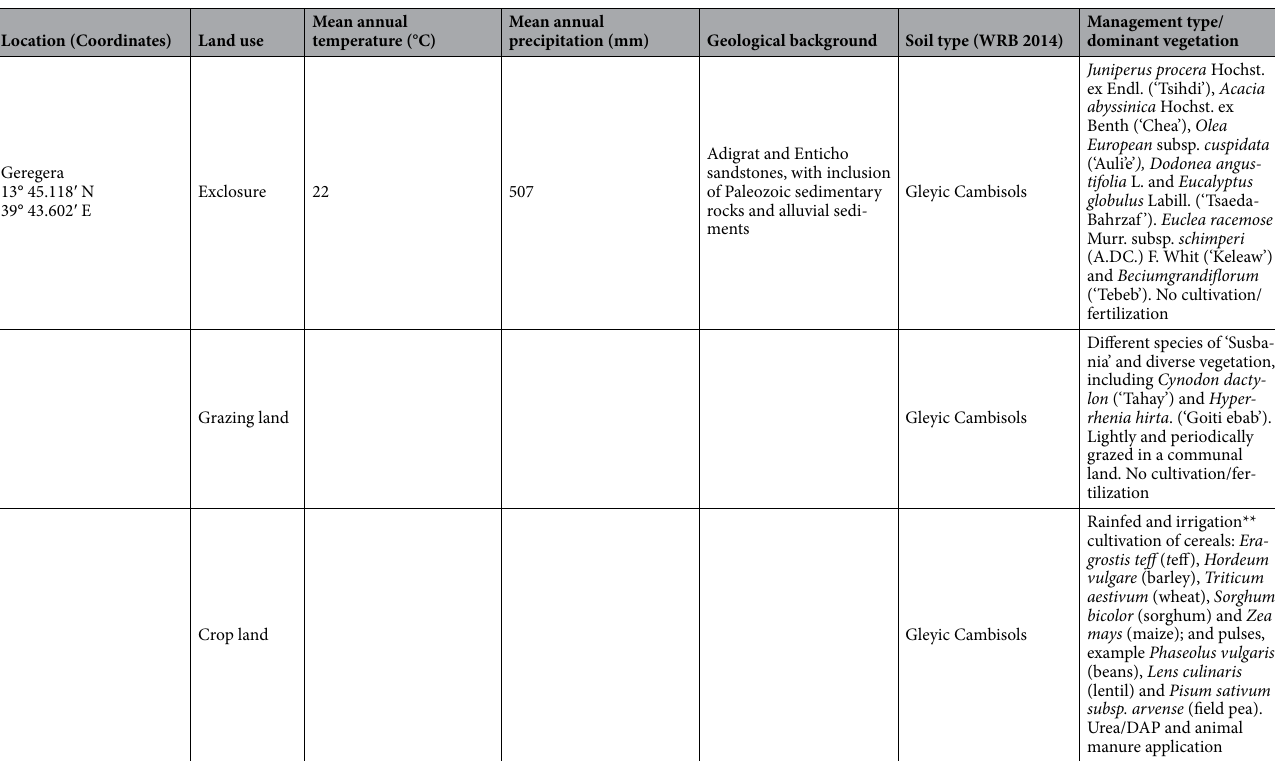
Table 1. Site description and meteorological data of study sites. The last crops at the point of sampling are the first two crops in each cropland and all sampled cropland soils were under rainfed cereal cultivation (Adapted from Okolo et al. 42,88 ) **Irrigated croplands are among the major land use types in Geregera watershed as practiced by the local smallholder farmers but the irrigated croplands were not sampled in this